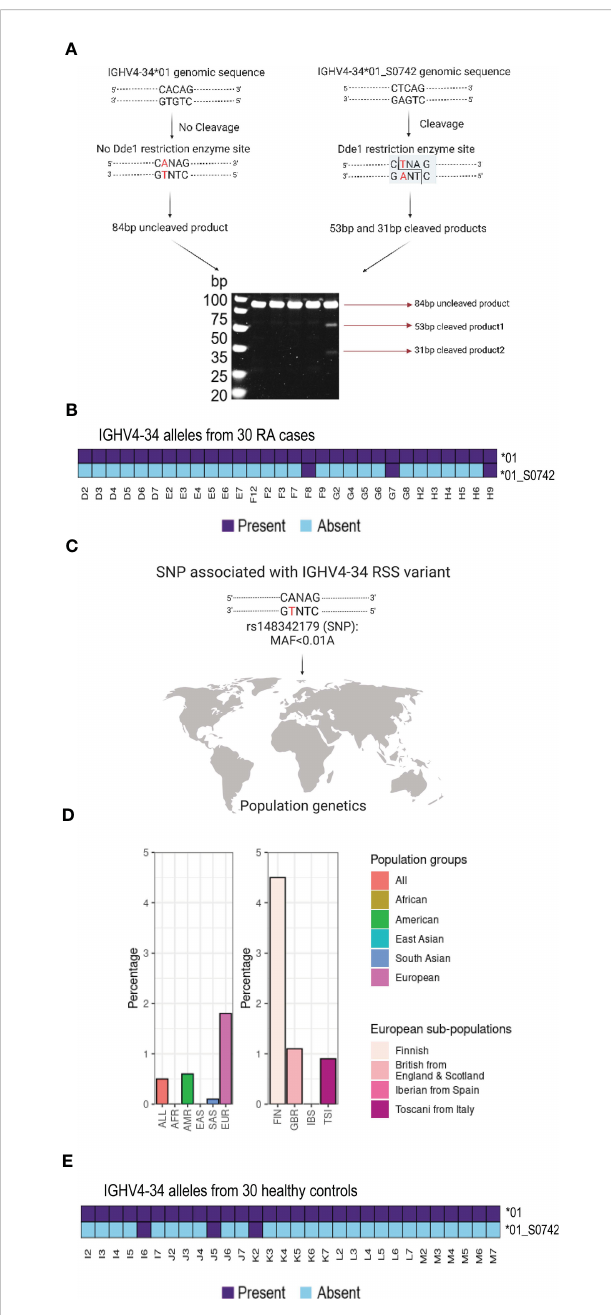
FIGURE 3 RSS variant analysis in the study group and in populations (A) Scheme of the restriction fragment length polymorphism is shown. (B) Three RA individuals contain the RSS variant of the IGHV4-34 gene (IGHV4- 34*01_S0742). (C) Schematic overview of the SNP number associated with the polymorphism (D) Data from the 1000 Genomes Project reveals that the coding minus strand has a T/A variant in SNP rs148342179 that is especially frequent in the Finnish (FIN) population. (E) Three healthy controls contain the RSS variant of the IGHV4-34 gene